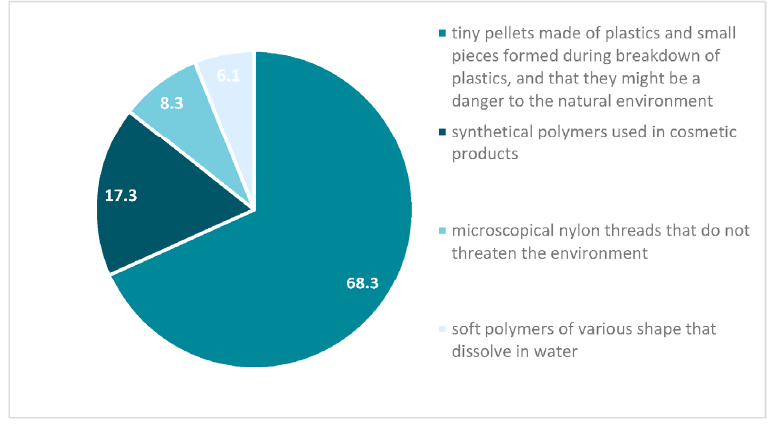
Figure 2. Respondents’ answers to “What are microplastics?” (%).